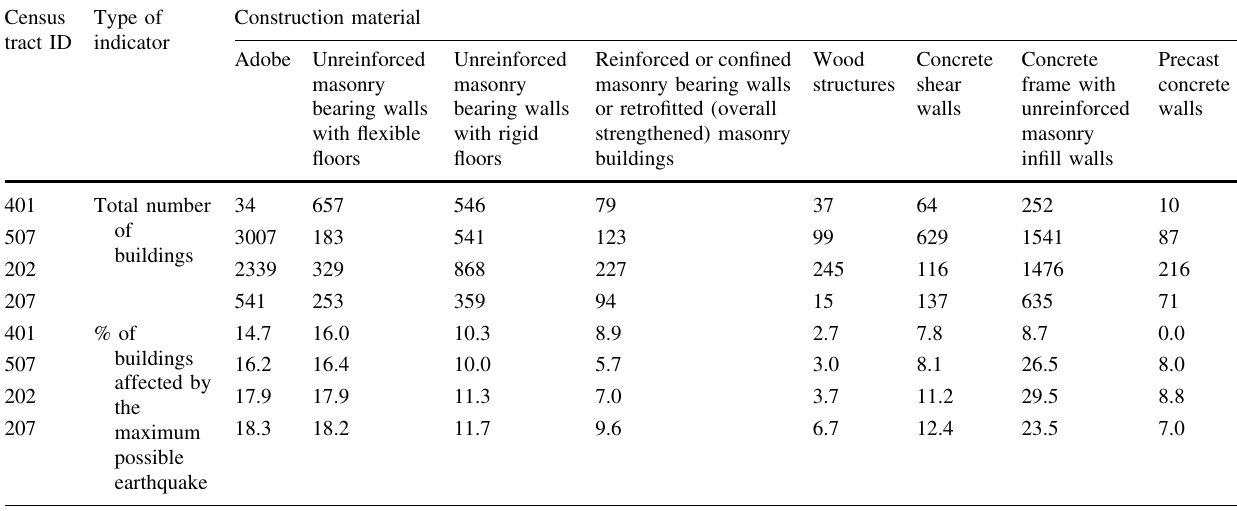
Table 5 Characteristics of the four census tracts selected for uncertainty analysis, in terms of number of buildings and loss estimation results for the maximum earthquake scenario, according to different construction materials (defined according to SeisDaRo classification) Census Type of tract ID